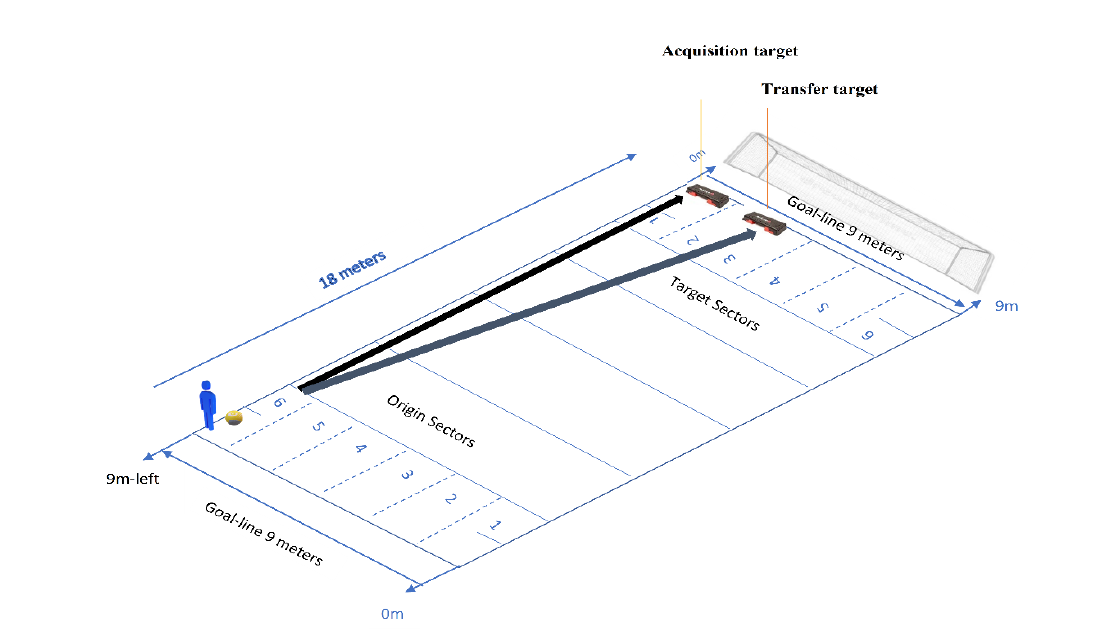
Figure 1 . A participant standing at the ready position and performing the acquisition and transfer